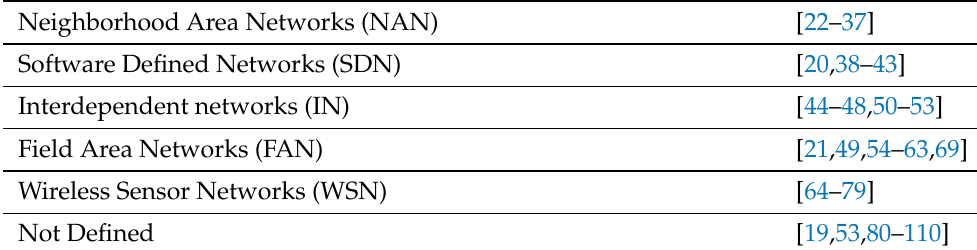
Table 1. Articles that can be classified by means of their Network